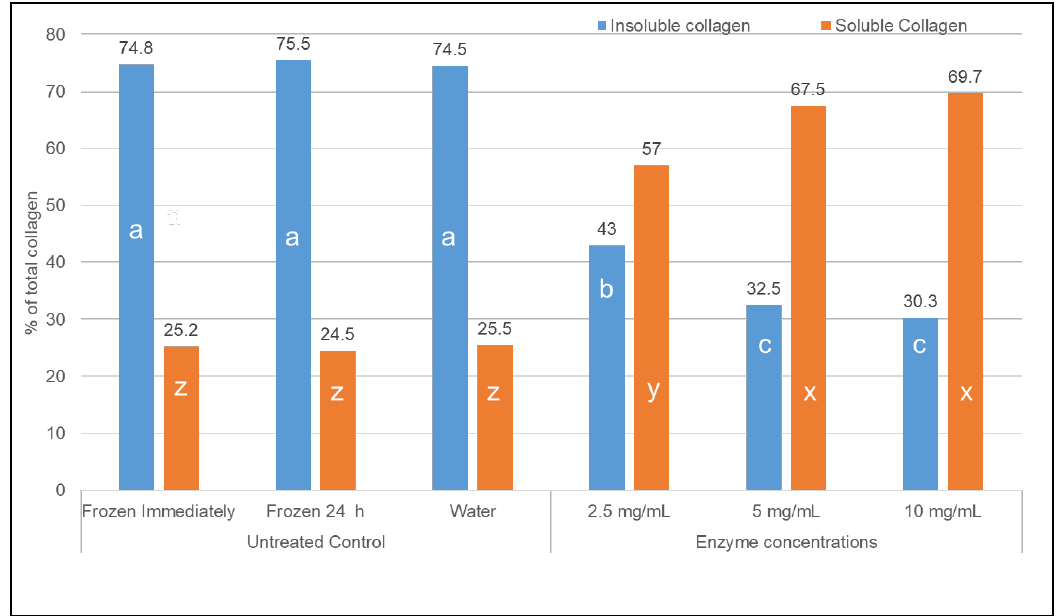
Figure 2. Effect of collagenase at different concentrations on insoluble and soluble collagen (% of total collagen) in ground woody breast meat. Letters a, b, and c represent significant differences in insoluble collagen while letter x, y, and z represent significant differences in soluble collagen among the treatments (p ≤ 0.05).